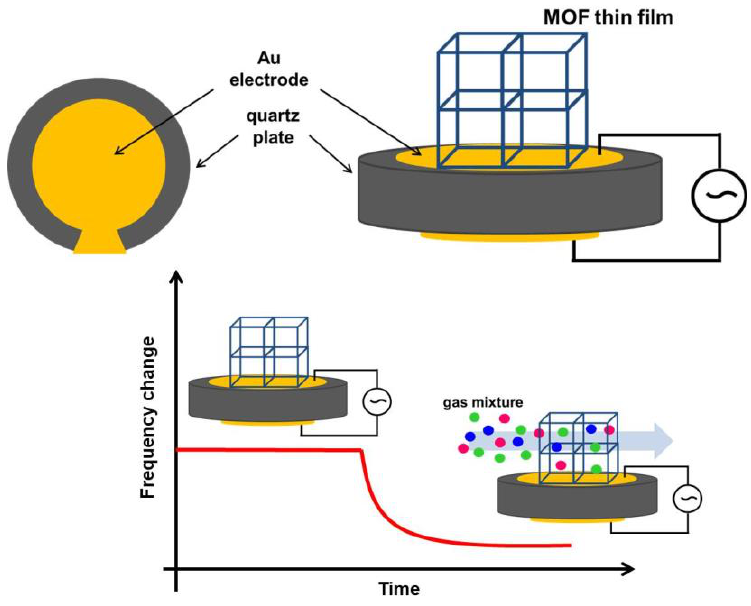
Figure 5. Scheme of MOF-based QCM gas sensor.